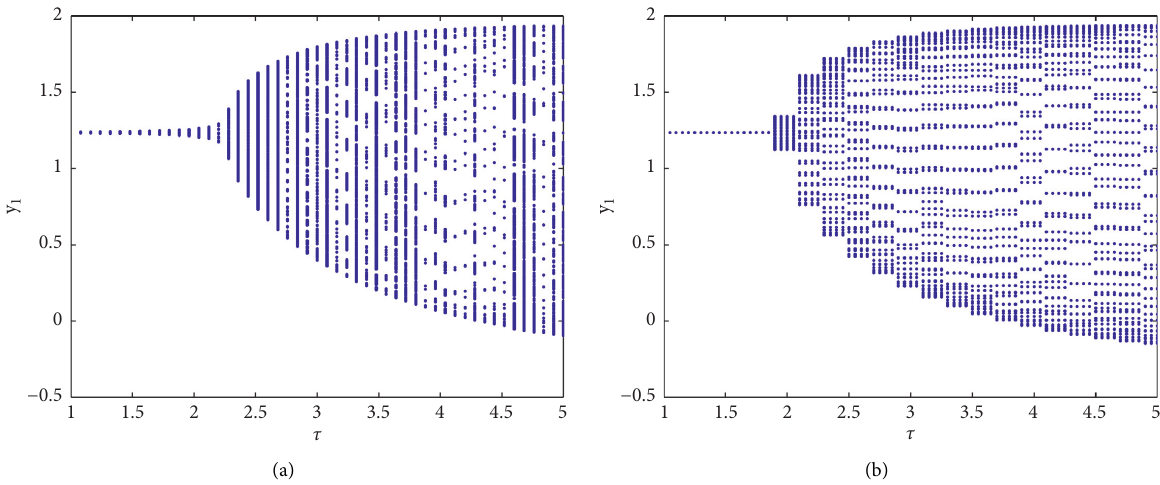
Figure 9: The bifurcation diagram of the system for y